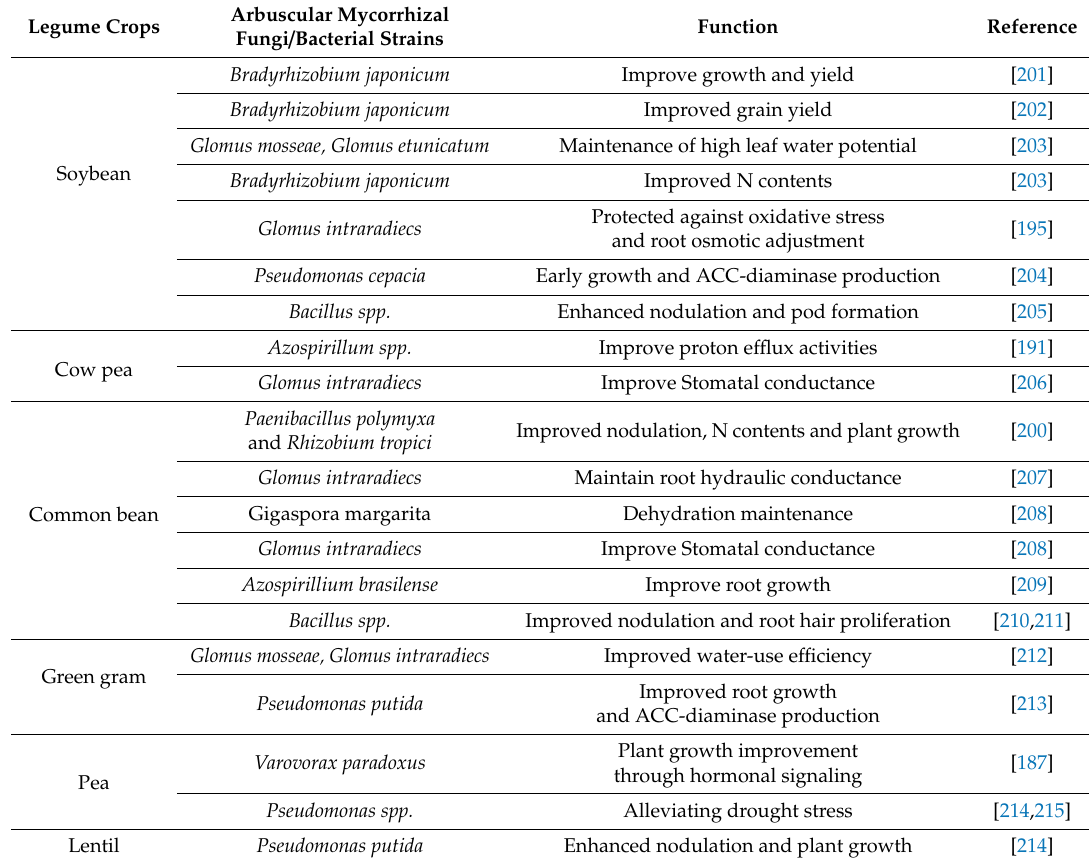
Table 3. Influence of arbuscular mycorrhizal fungi and rhizobacteria on drought resistance in grain